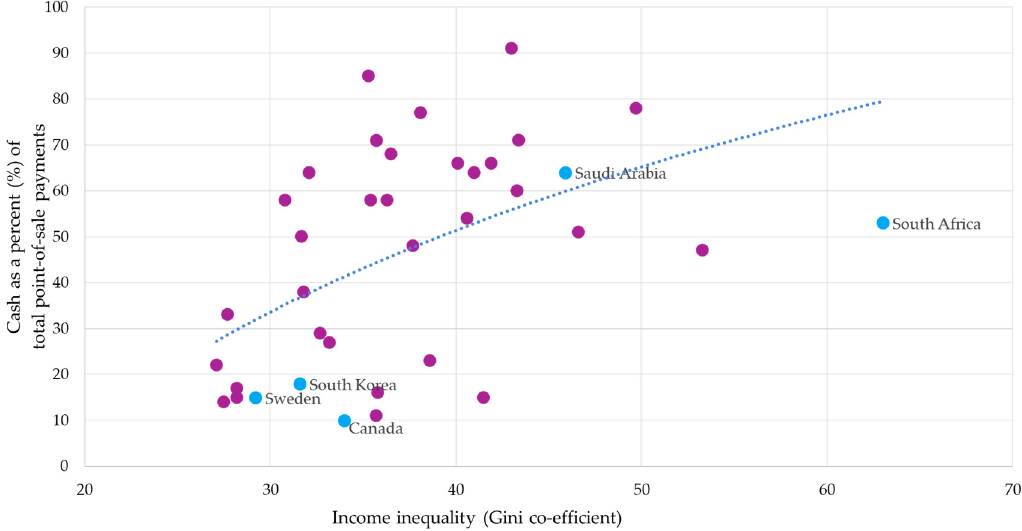
Figure 3. Value of total payments transacted in cash versus income inequality for 37 emerging and advanced economies, 2019. The Gini coefficient for Saudi Arabia relates to 2014 and was obtained from the World Bank’s World Development Indicators. The countries included in the sample are listed in Appendix A (UNDP 2019; FIS 2020).